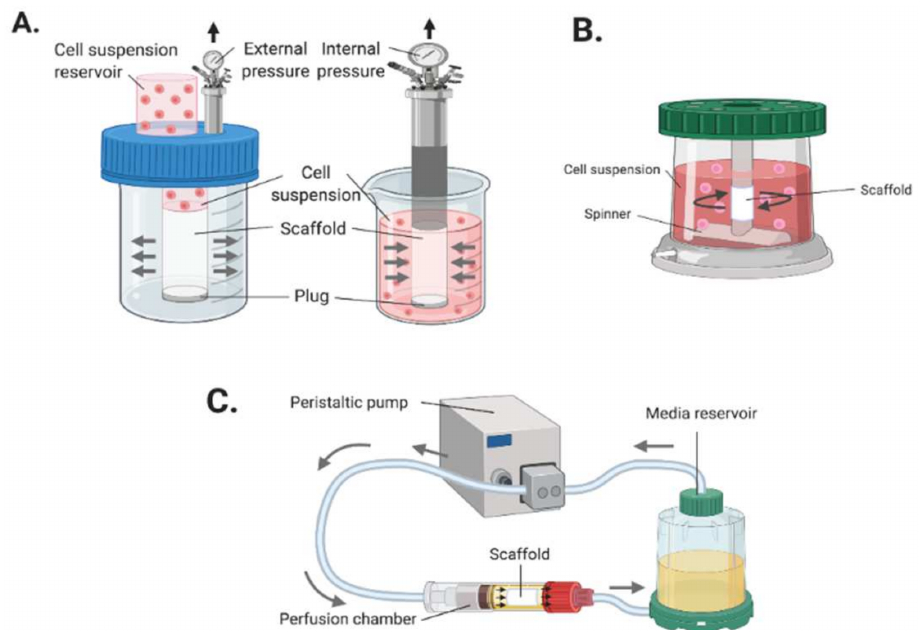
Figure 6. Dynamic seeding methods. ( A ) Vacuum seeding: using internal or external pressure forces to drive cells into scaffolds. ( B ) Centrifugal/rotational seeding: using rotational force to drives cells into the scaffold. ( C ) Perfusion seeding: mimicking the in vivo physiological conditions and biomechanical stress of blood vessels to aid cell attachment to the scaffold. (Created with BioRender.com, accessed on 8 January 2022).